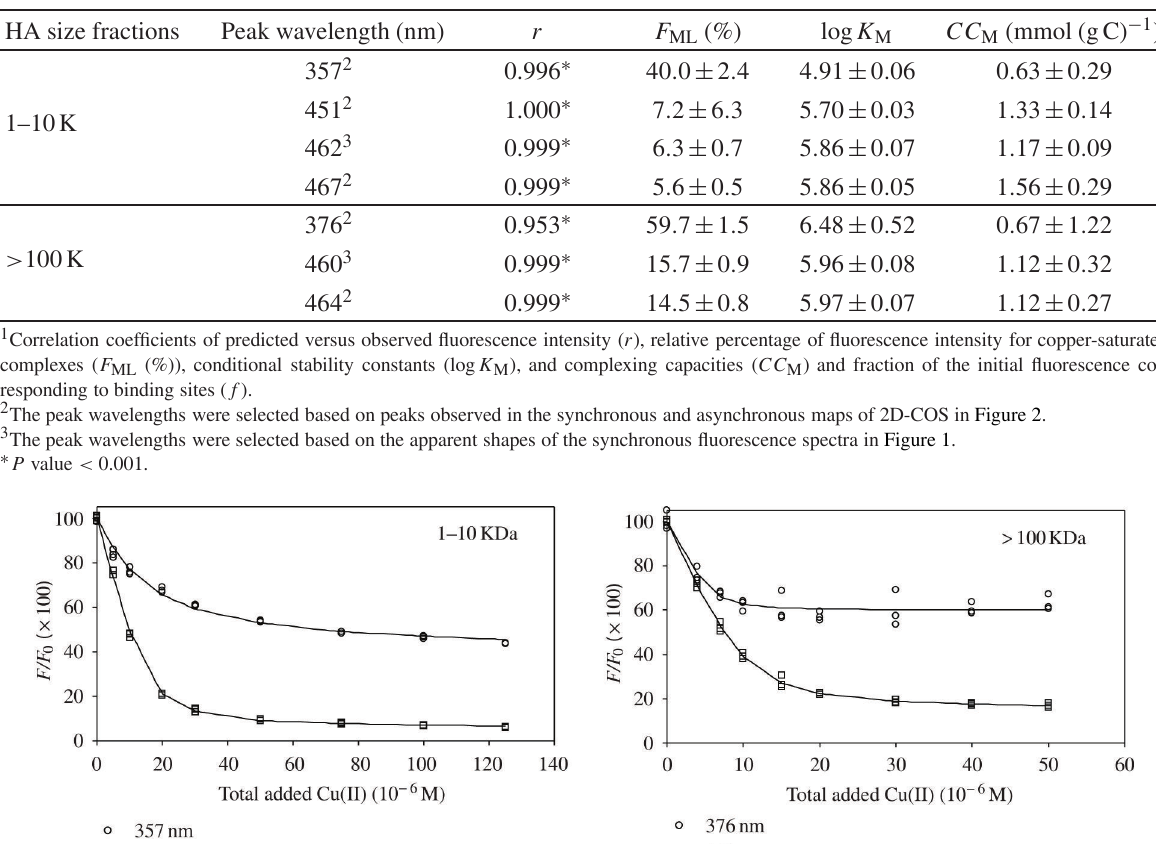
TABLE 2: Copper-binding parameters 1 calculated by the Ryan-Weber model.